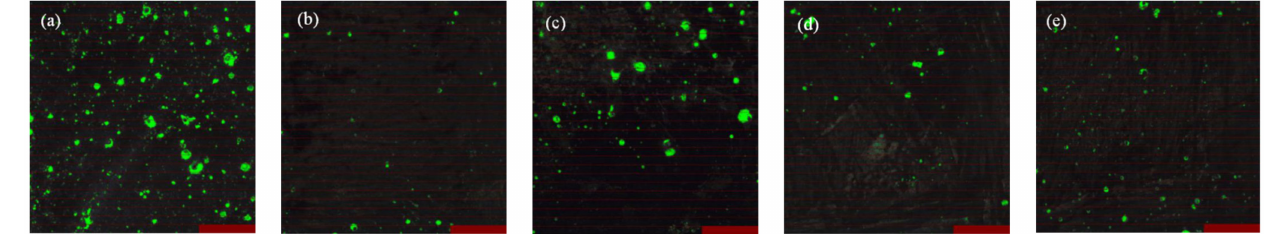
Figure 9. Scanning diagram of pore structure of grouting material. ( a ) Undoped; ( b ) 1.2% NF; ( c ) 0.4% NA; ( d ) 1.6% NM; ( e ) 0.8%